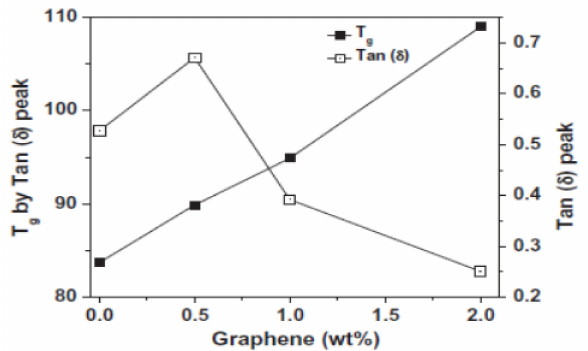
Figure 6. The Tg and the tan δ values vs. weight fractions of graphene in the PVC matrix [106]. A restriction in the chain mobility induced by the graphene layers (GN) in concen- trations in the PVC matrix up to 3wt.%, followed by a significant augmentation of the Tg , was confirmed for the nanocomposite fibers [107]. The Tg value of the composites was estimated from the DSC thermograms, showing a characteristic inflection point in the temperature range 77–94 ◦ C for all PVC/GN fibers; the Tg of the sample containing 3 wt.% GN was by about 6 ◦ C higher than that of pure PVC. Mindivan F. et al. have reported that the increase in Tg in PVC composites containing from 0.1 wt.% up to 1.0 wt.% of graphene nanoplatelets (GNP) indicates a restriction in segmental relaxation. However, due to the formation of hydrogen bonds between GNP and the polymer, the Tg values of all nanocomposites (between 34.99 ◦ C and 44.36 ◦ C) were lower than that of the neat PVC (44.71 ◦ C)